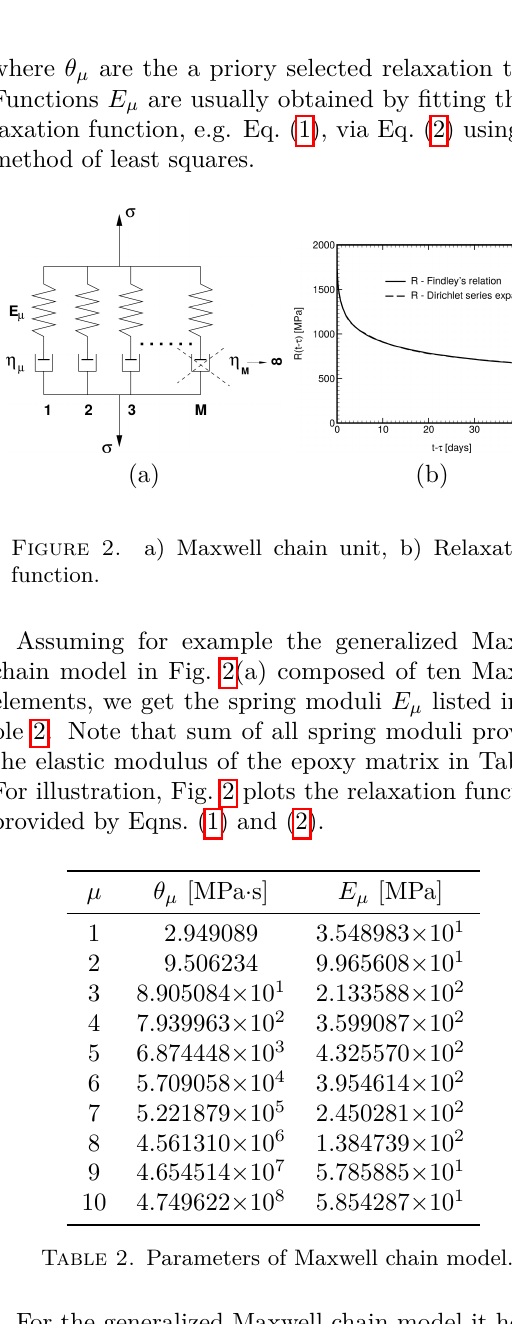
Table 1. Material properties of individual phases.